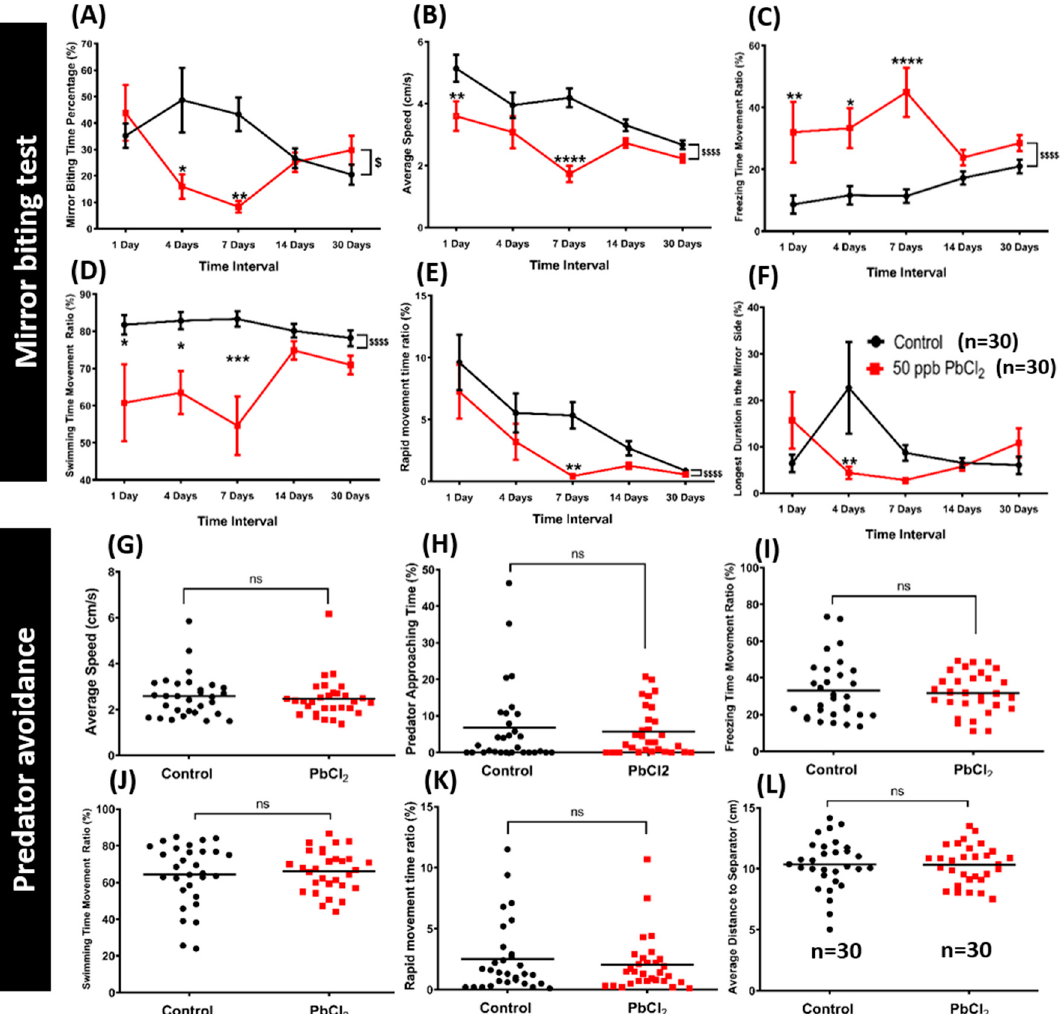
Figure 4. Evaluation of aggressiveness and fear by mirror-biting and predator avoidance tests between the control and 50 ppb PbCl 2 -treated fish. After PbCl 2 exposure (red line), the mirror biting behavior was chronologically monitored and the data were presented as ( A ) mirror biting time percentage, ( B ) average speed, ( C ) freezing time movement ratio, ( D ) swimming time movement ratio, ( E ) rapid movement time ratio, and ( F ) longest duration in the mirror side. Data are expressed as mean ± SEM values and analyzed by two-way ANOVA with Sidak’s multiple comparisons test ( n 1 & 7 days = 10, n 14 days = 40, n 30 days = 30; * / $ p ≤ 0.05, ** p ≤ 0.01, *** p ≤ 0.001 and **** / $$$$ p ≤ 0.0001). After PbCl 2 exposure for 30 days, the predator avoidance behavior was monitored and data were presented as ( G ) average speed, ( H ) predator approaching time, ( I ) freezing time movement ratio, ( J ) swimming time movement ratio, ( K ) rapid movement time ratio, and ( L ) average distance to separator. Data are expressed as mean and analyzed by the Mann–Whitney test ( n = 30).